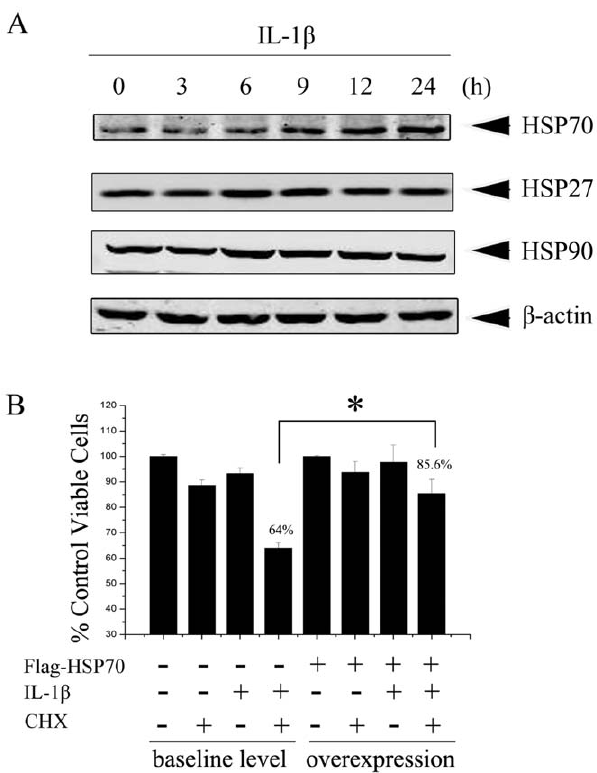
Figure 1. Inducible HSP70 antagonized IL-1 b -induced cytotoxic effect on HeLa cells and improved the cell survival. (A) HeLa cells were stimulated with IL-1 b (10 ng/ml) for indicated times, HSP70, HSP27, HSP90, and b -actin levels were determined by Western blotting. (B) HeLa cells were transfected with pcDNA3.0 ( 2 ) or pcDNA3.0-Flag- HSP70 ( + ). After 48 h, cells with either baseline level of or over- expression of HSP70 were exposed to IL-1 b (10 ng/ml) or CHX (1 m g/ml) or both for 24 h. Cell viability was subsequently detected by CCK8 assay as described in Material and Methods. Cell viability is shown relative to the untreated control. The experiment was independently repeated for three times and data were shown as mean 6 SD; bars: SD. Significant difference was determined by student’s t -test comparing